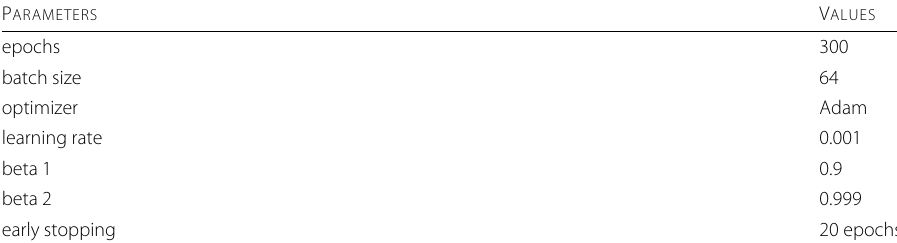
Table 1 The parameters of our GAF-CNN model P ARAMETERS